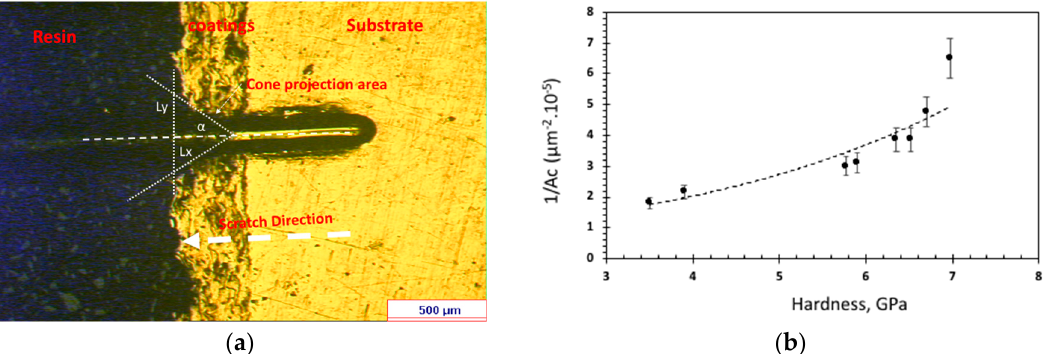
Figure 5. ( a ) Wear footprint micrography of 331 kPa oxygen and 69 kPa acetylene sample with a load of 5 N; ( b ) Inverse of the cone footprint area vs. hardness of the aluminum-bronze coatings (the trend lines are shown as a visual aid).